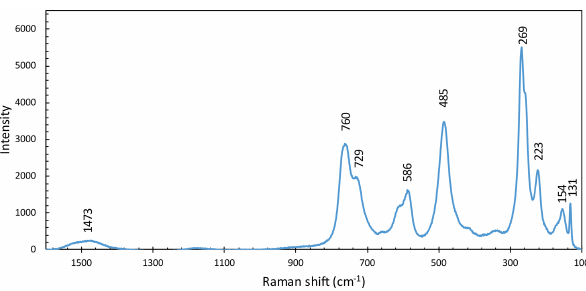
Figure 4. Raman spectrum of monteneveite from 1600 to 100cm − 1 with the most prominent peaks indicated.